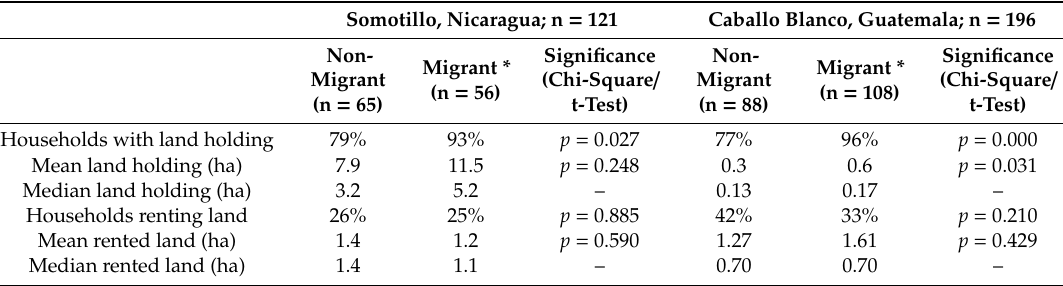
Table 1. Land Access in the Case Study